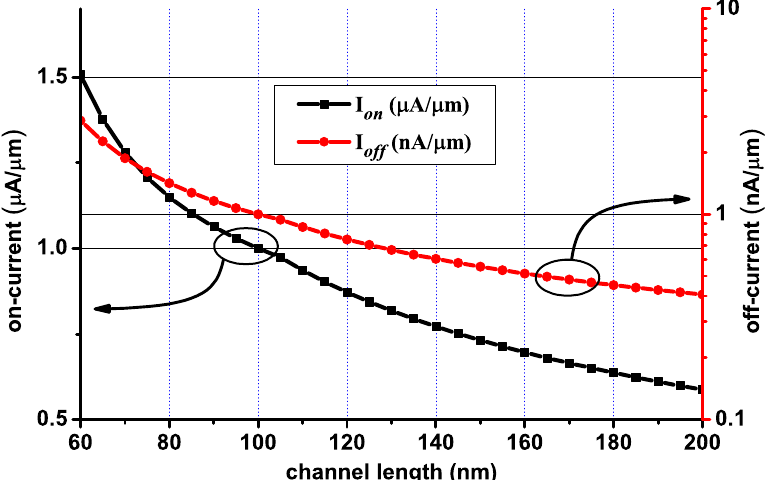
Figure 5. Normalized on- and off-stage current for different channel length (FF corner and 120 ◦ C temperature). They are normalized to the current of the 100 nm channel length. Trip